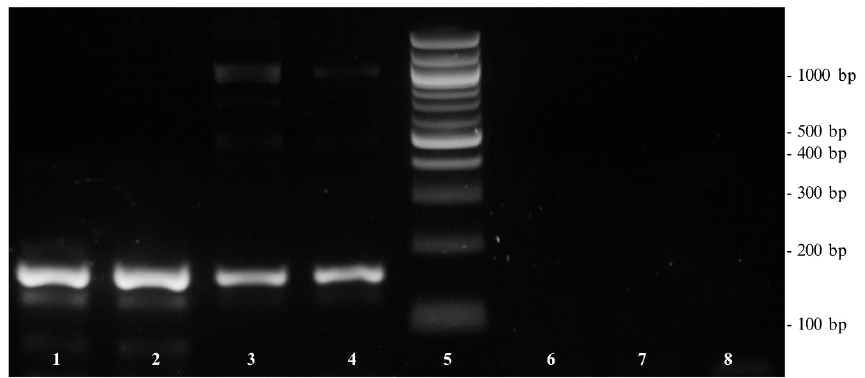
Figure 2. Gel electrophoresis of DNA extracted from coconut, coconut chips, and coconut blossom sugar. Lane 1–2: coconut chips; lane 3–4: coconut; lane 5: 100 bp DNA ladder; lane 6–7: coconut blossom sugar; lane 8: non-template sample with water.